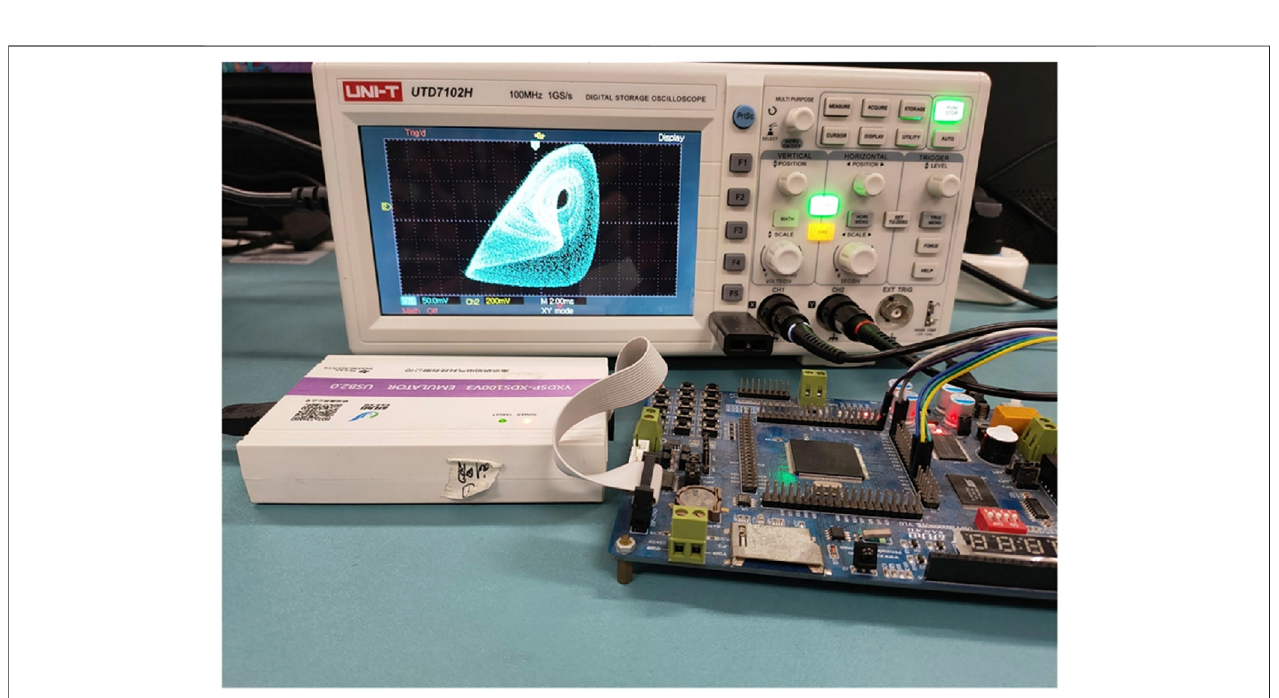
FIGURE 12 | DSP simulation physical